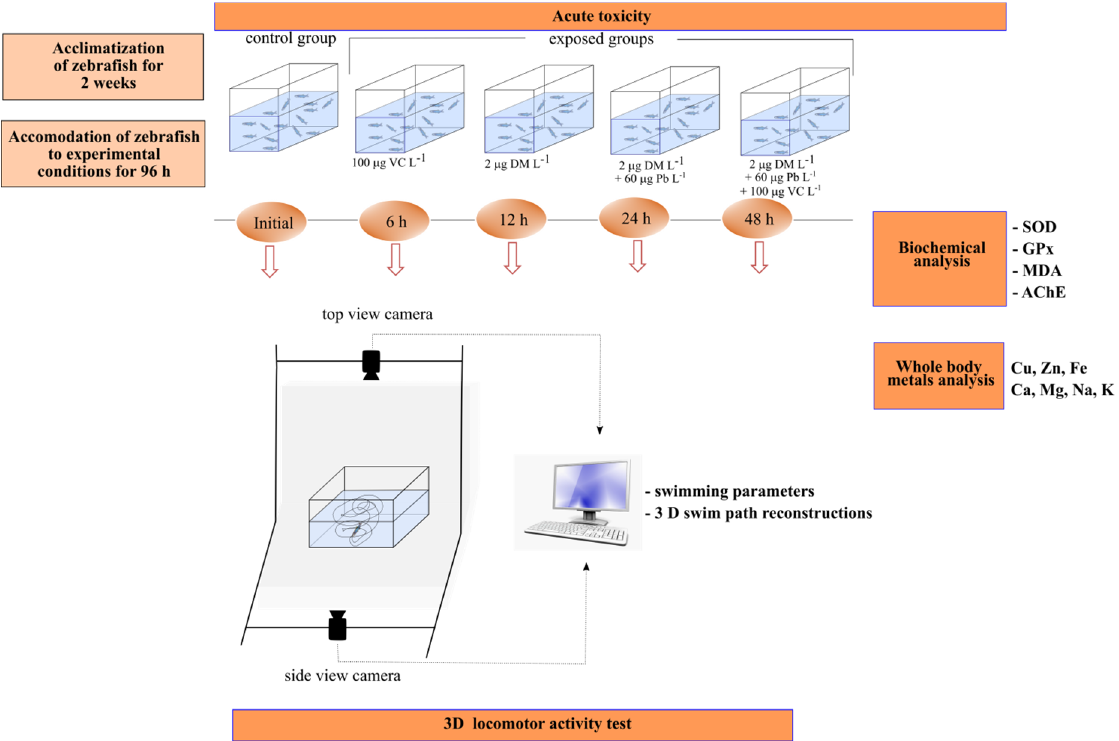
Figure 5. The schematic representation of the experimental setup used to elucidate the potential toxic effect of DM in combination with Pb on zebrafish and its possible amelioration by vitamin C supplementation.